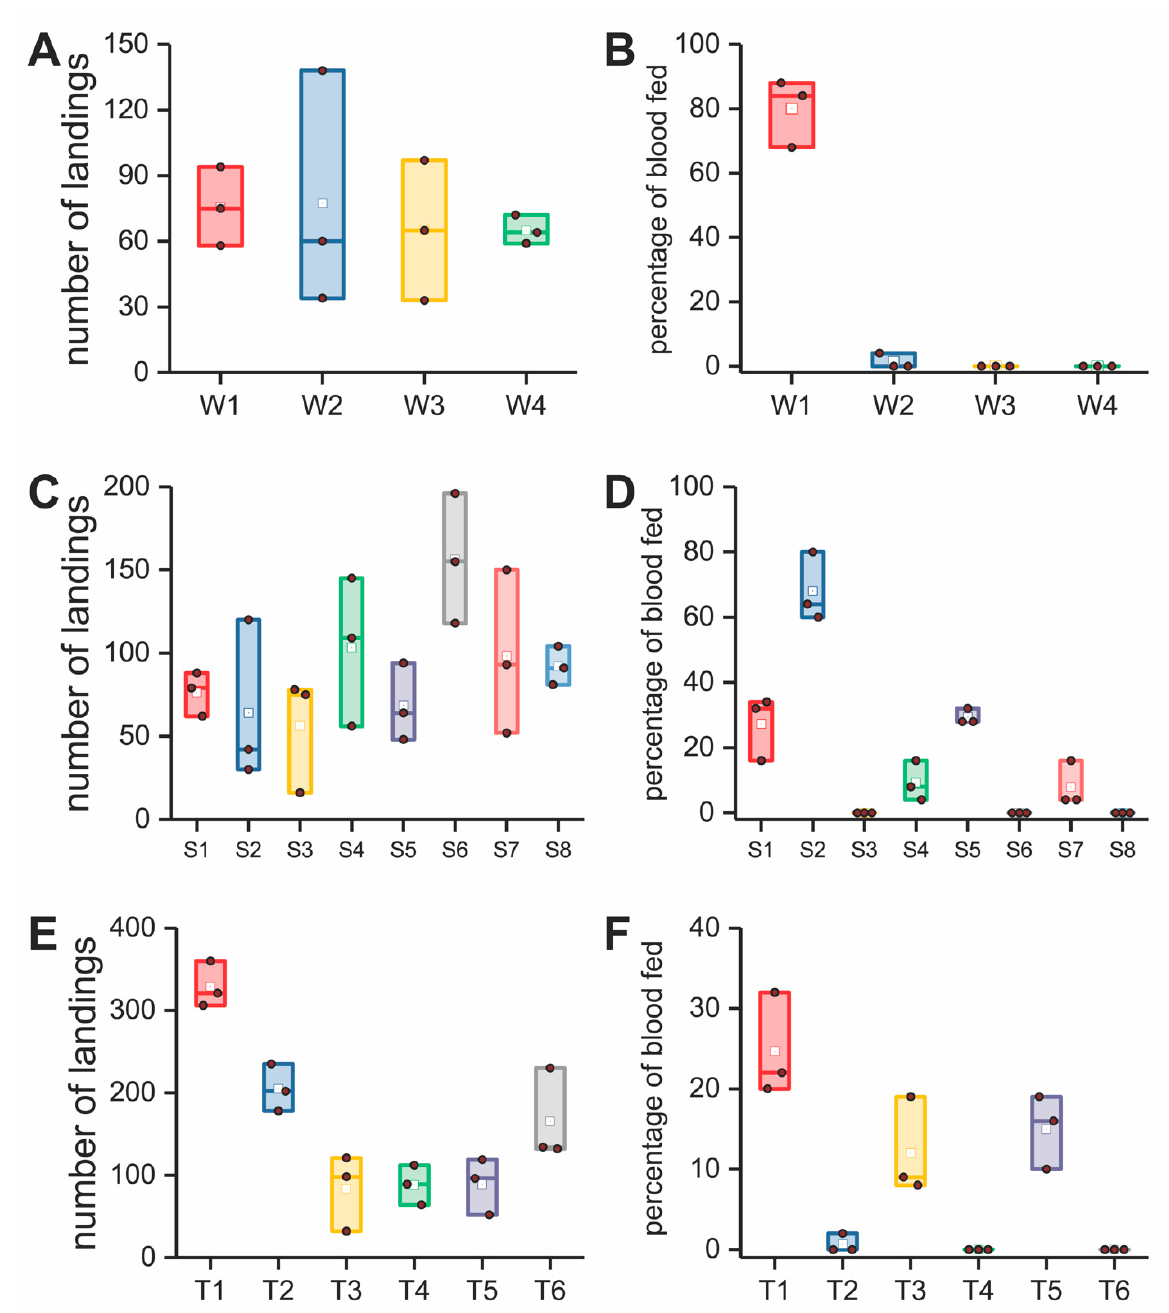
Figure 4. In vitro bioassay results for the woven structures, plastic plates, and knitted and knitted spacer fabrics (see Table 1 for the pore size and thickness, model prediction, and whether the prediction was accurate; Figure 3B for the position of the woven structures and plastic plates relative to the safe and unsafe barriers predicted by the model). ( A ) Number of landings on the woven structures. ( B ) Percentage of blood fed on by mosquitoes on woven structures. ( C ) Number of landings on plastic plates. ( D ) Percentage of blood fed on by mosquitoes on plastic plates. ( E ) Number of landings on knitted fabrics. ( F ) Percentage of blood fed on by mosquitoes on knitted fabrics. Abbreviations used: W1 to W4 = Case 1 woven filtration structures; S1 to S8 = Cases 2 and 3 plastic spacer blocks; T1 to T6 = Cases 1–3 knitted and spacer (3D) knitted textiles (see Table 1 for more detailed definitions of the abbreviations).